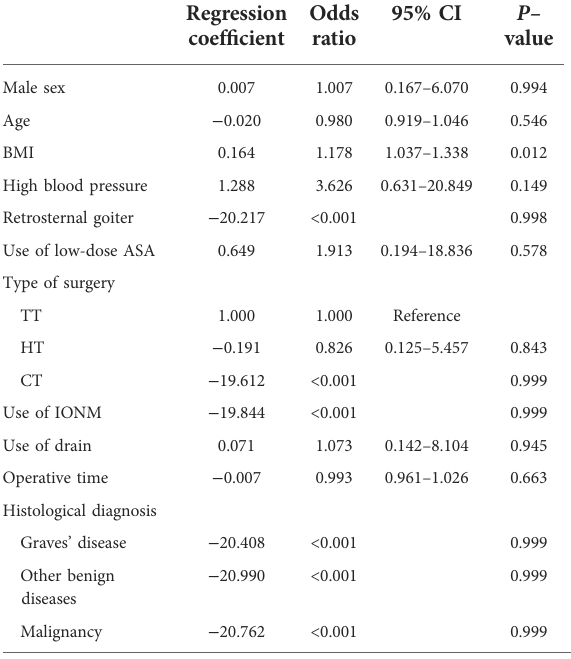
TABLE 4 Multivariate analysis of potential risk factors for cervical